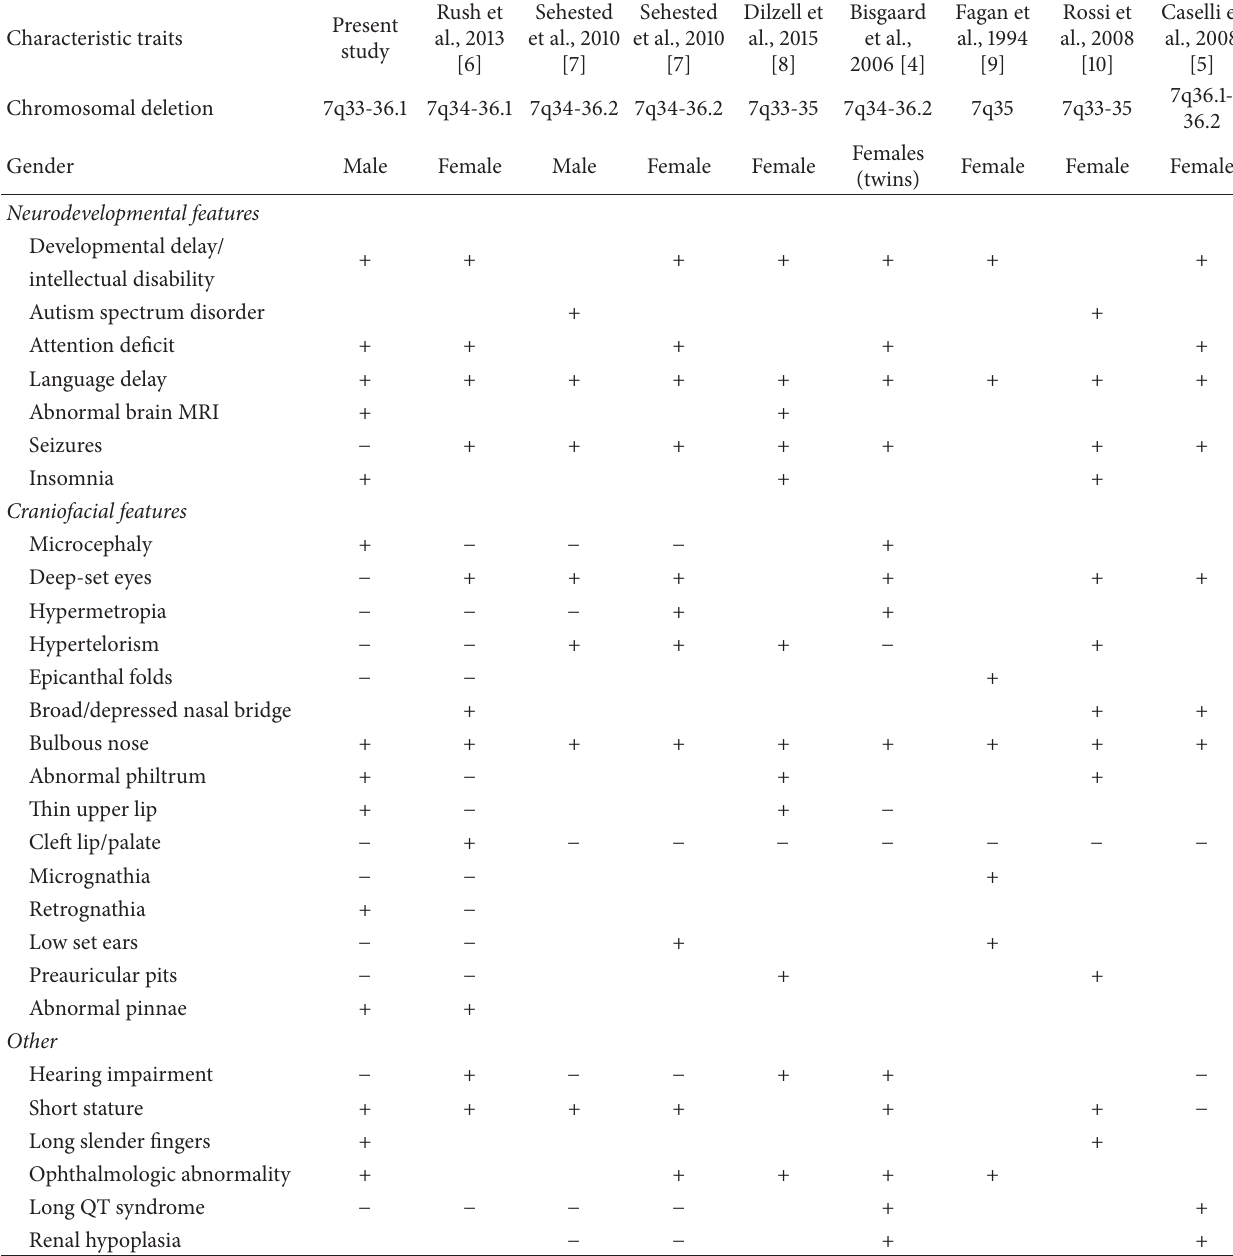
Table 1: Clinical features in patients with interstitial deletions overlapping the 7q33-36.1